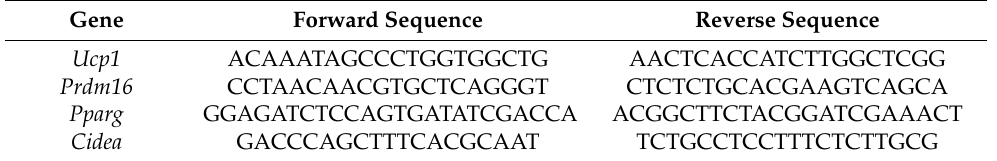
Table 1. Primer sequences used for quantitative real-time PCR.